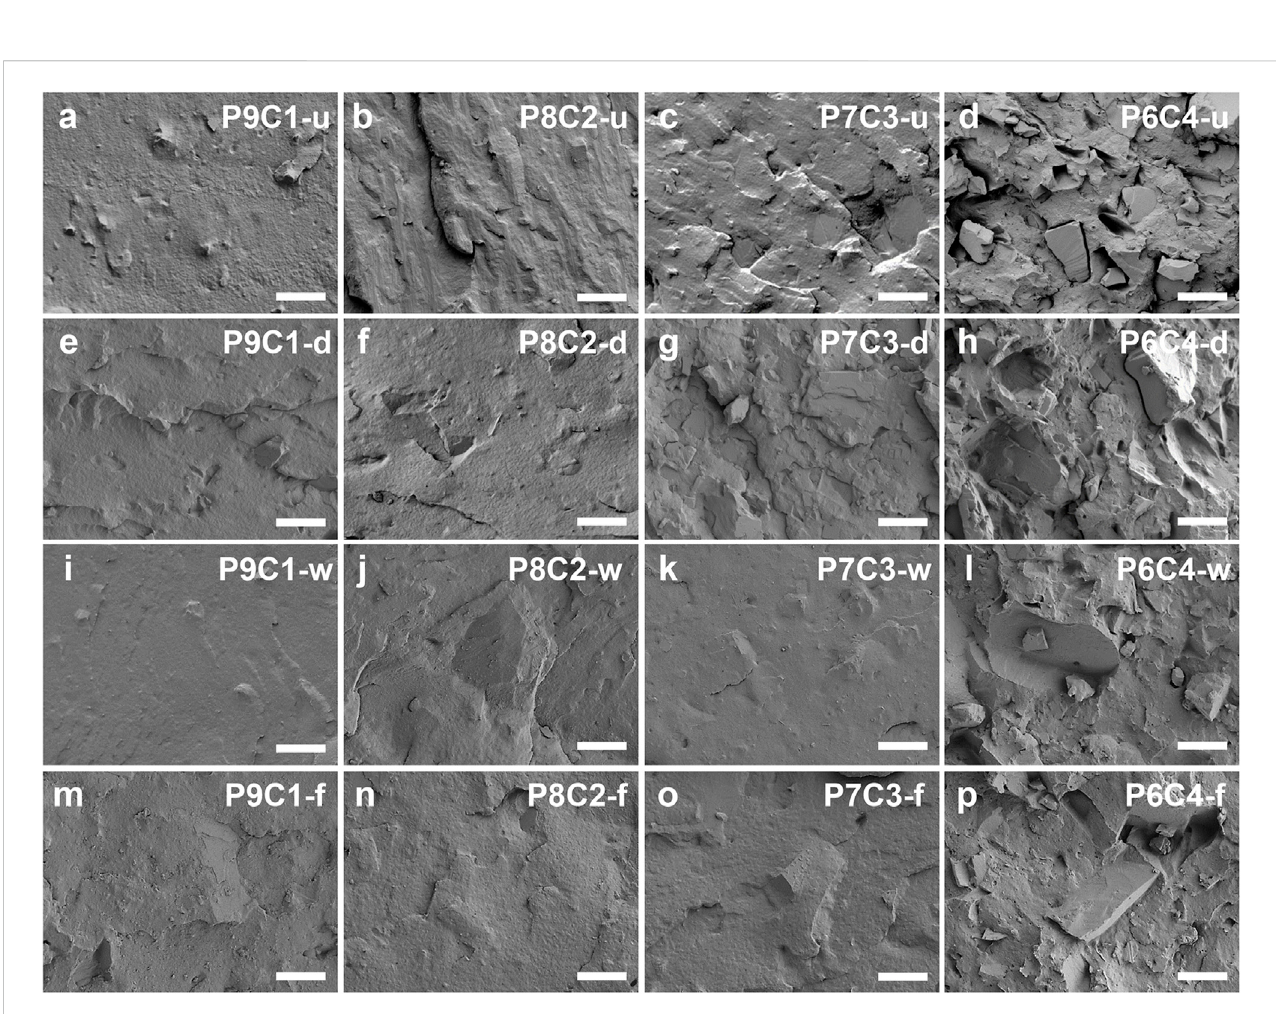
FIGURE 6 SEM images of PBAT composites fi lled with (A) 10, (B) 20, (C) 30, and (D) 40 wt.% of unmodi fi ed CaCO 3 ; composites fi lled with (E) 10, (F) 20, (G) 30, and (H) 40 wt.%ofdry-modi fi